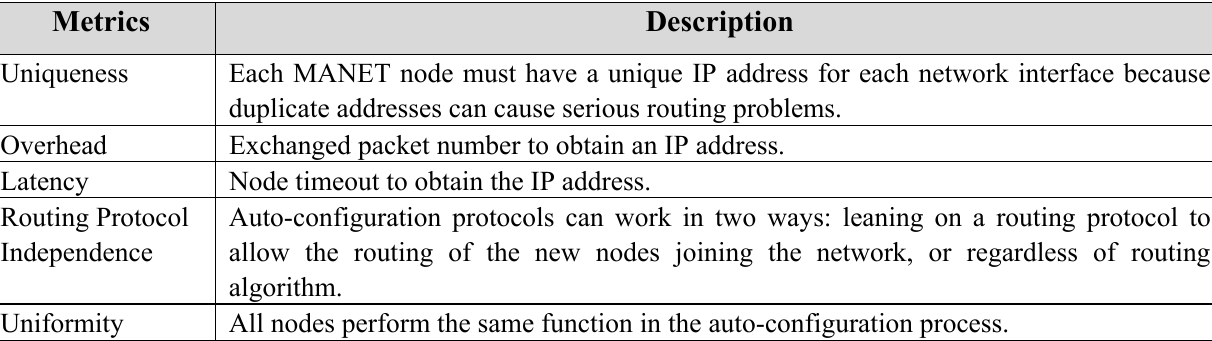
Table 1. Evaluation metrics.